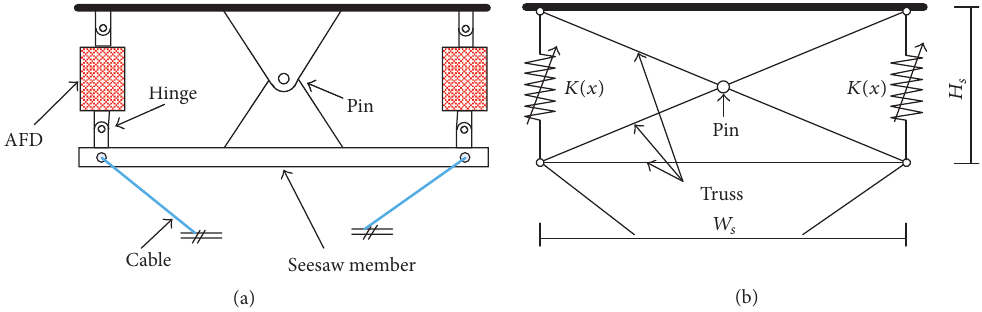
Figure 7: Model of vibration control system: (a) details of vibration control system and (b) analysis model.